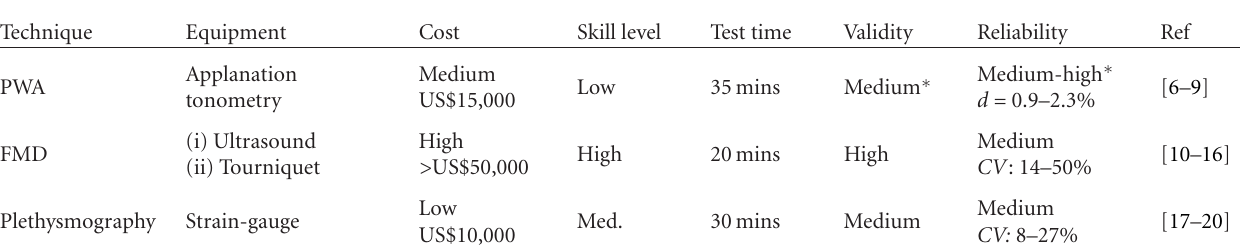
Table 1: Comparison of noninvasive techniques for assessing endothelial